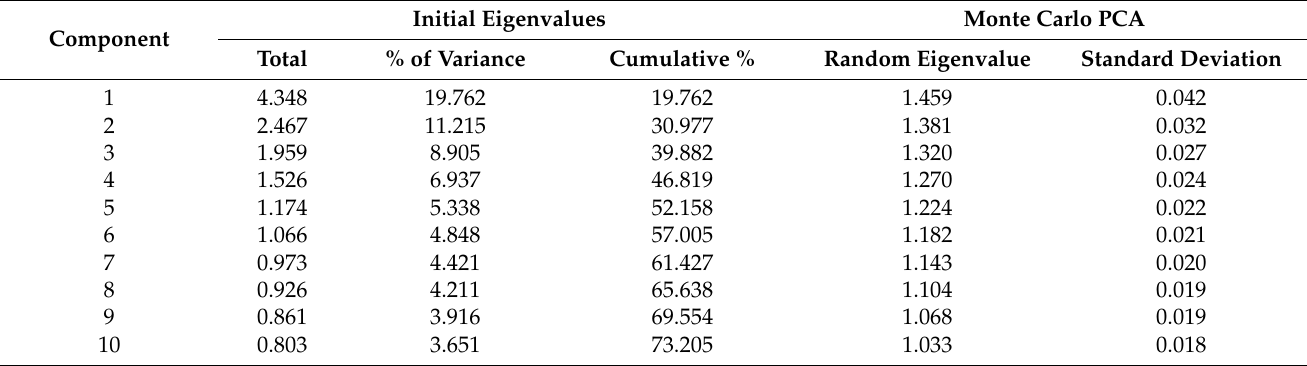
Table 1. Eigenvalues and Monte Carlo